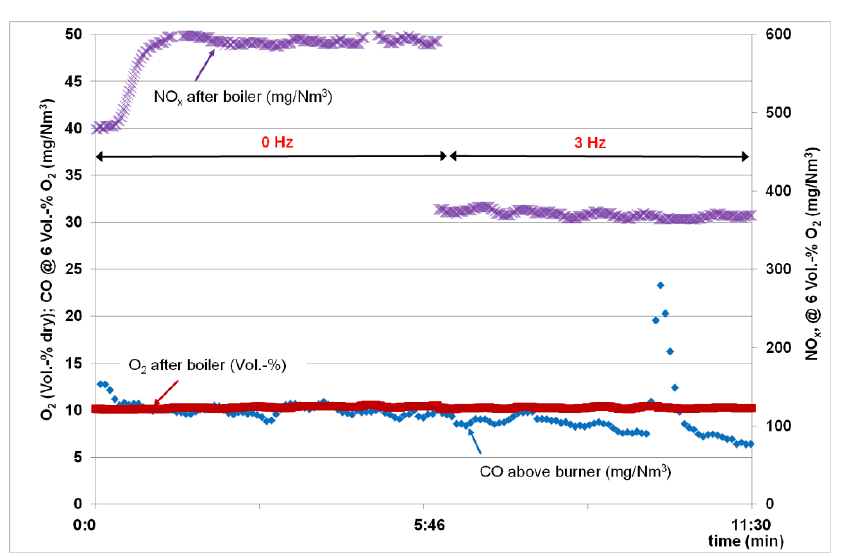
Figure 9. Concentrations of CO, NO x , and O 2 for non-oscillating and oscillating operation. From test series B, an exemplary period was selected, which shows the influence of oscillation on nitrogen oxide concentration (Figure 9). The left y-axis shows the oxygen content downstream of the boiler in percent by volume (dry basis), and the CO content upstream of the burner standardized to 6% by volume oxygen. The NO x downstream of the boiler is plotted on the right y-axis opposite the test time. The reduction in NO x through oscillation at 3 Hz from around 600 mg/Nm 3 to 370 mg/Nm 3 based on 6% volume O 2 is clearly visible. In this case, the hard coal mass flow dosed via the annular gap R1 was oscillated. However, the different combinations of fuel mass flow and air volume flow according to Table 1 changed the total air ratio at the burner. The local air ratio, which is crucial for the NO x reduction potential, could unfortunately not be